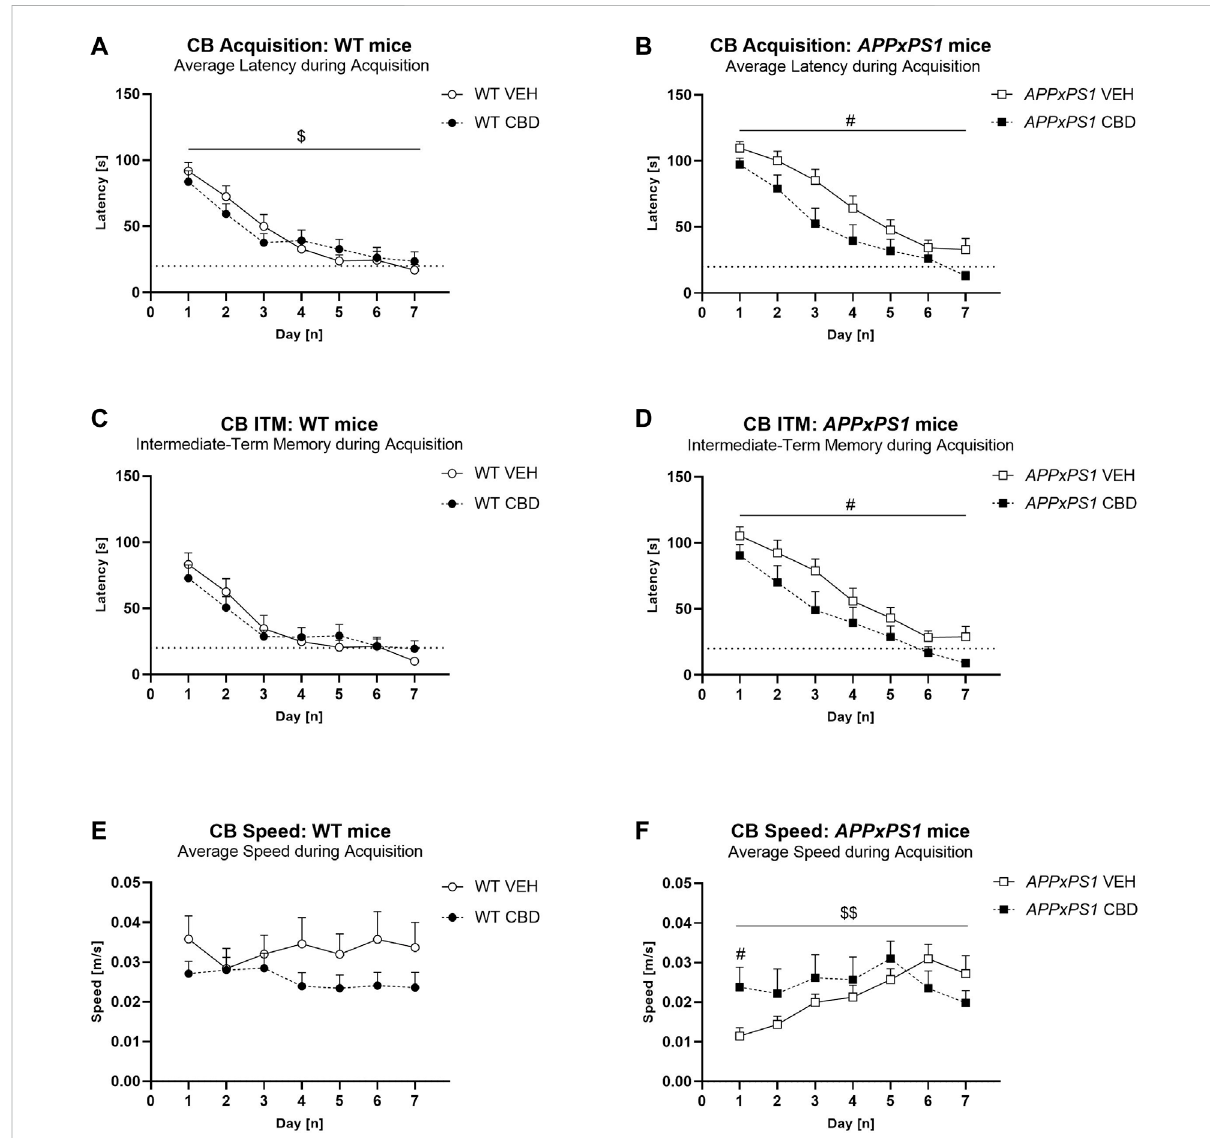
FIGURE 2 Long-term CBD improves average latency, intermediate-term memory latency, and speed during cheeseboard acquisition in APPxPS1 female mice. Latency [s] and speed [m/s] when fi nding the food reward in the cheeseboard in APPxPS1 and WT mice treated daily with 20 mg/kg CBD for 8 months. (A,B) Average latency [s] to fi nd the food reward (averaged across 3 trials per day) during acquisition of the cheeseboard task. (C,D) Intermediate-termmemorylatency[s](i.e.,averagelatencyfortrials2and3ofeachday)duringacquisition. (E,F) Averagespeed[m/s](averaged across three trials per day) during cheeseboard acquisition. The dotted line in (A – D) indicates the 20-s cut-off threshold for acquisition. In (A,B), a “ days ” × “ genotype ” interaction ( p = 0.02) was detected, and in (C,D), a “ days “ × “ genotype ” interaction ( p = 0.004) was detected. In ( E,F) , a “ days “ × “ treatment ” interaction was detected; when split by “ treatment, ” there was a “ days ” × “ genotype ” interaction ( p = 0.02) in VEH-treated mice. Splitting by “ day ” con fi rmed “ genotype ” differencesondays1 – 3( p -values < 0.02).Dataanalysedusingthree-wayRMANOVAandpresentedasmean±SEMin separate graphs for visual clarity. When data were split by the corresponding factor, signi fi cant “ treatment ” effects in APPxPS1 mice are indicated by hash symbols ( # p < 0.05); interactions between “ treatment ” and “ days ” are indicated by ‘ $ ’ ( $ p < 0.05; $$ p < 0.01). N = 13 WT VEH, 16 APPxPS1